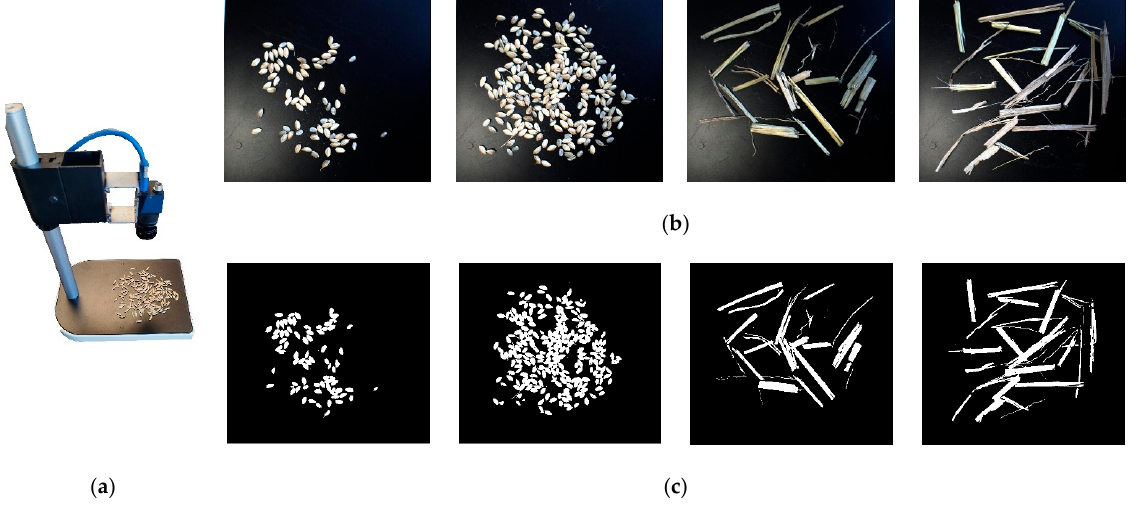
Figure 7. Material pixel density calibration test. ( a ) Calibration device; ( b ) calibration image; ( c ) binarized image.